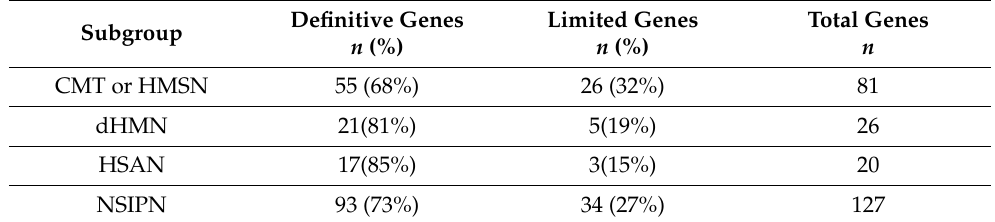
Table 1. Summary of National French consensual gene lists for the genetic diagnosis of